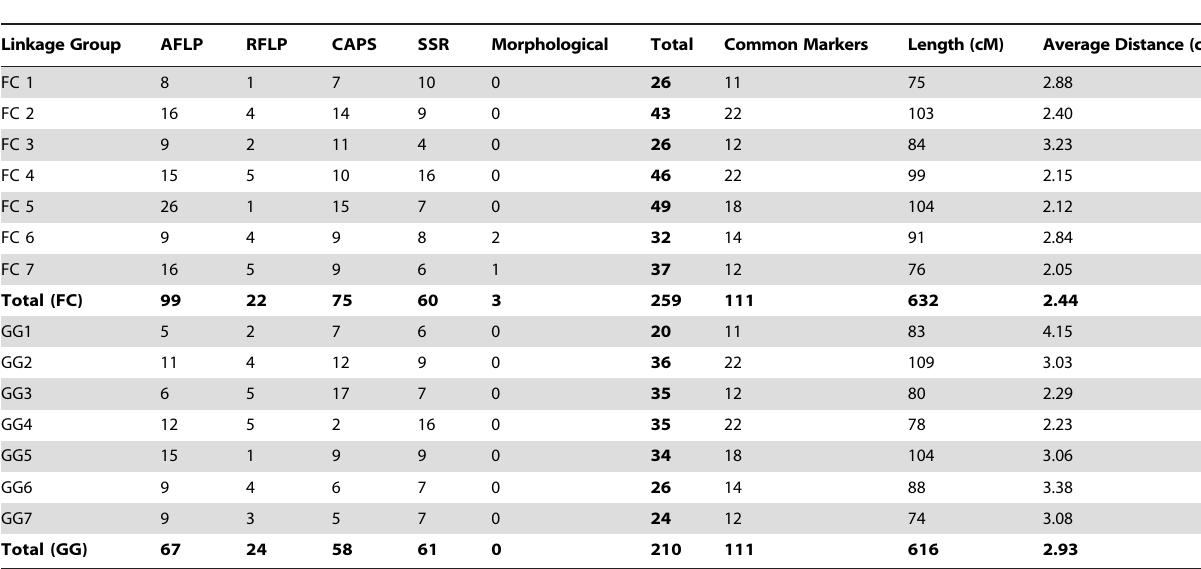
Table 2. Distribution of markers on parental maps (GG and FC) and linkage group statistics.